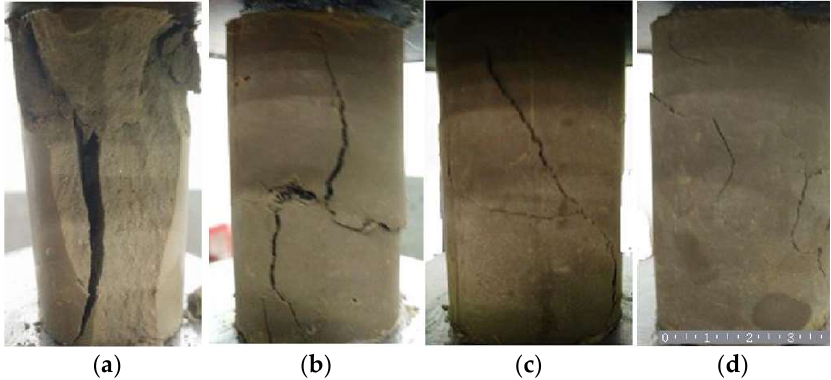
Figure 10. Failure pattern of fiber cement soil with different fiber content (1:1). ( a ) fiber content 0%; ( b ) fiber content 0.1%; ( c ) fiber content 0.2%; ( d ) fiber content 0.4%.